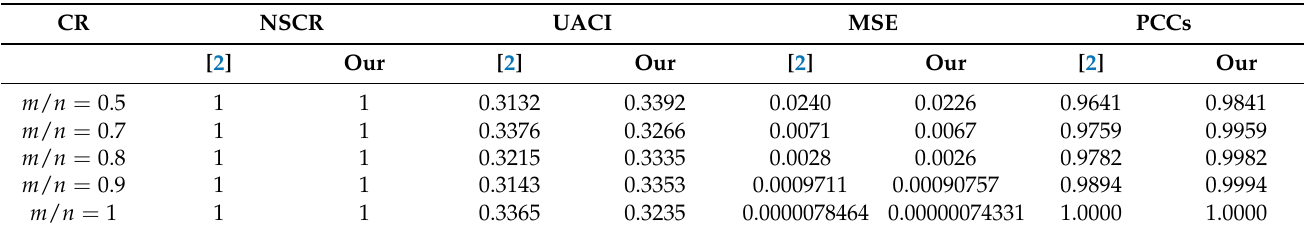
Table 2. NSCR, UACI, MSE, PCCs under different compression ratios (CR) in Moreno-Alvarado [2] and our scheme. CR NSCR UACI MSE PCCs